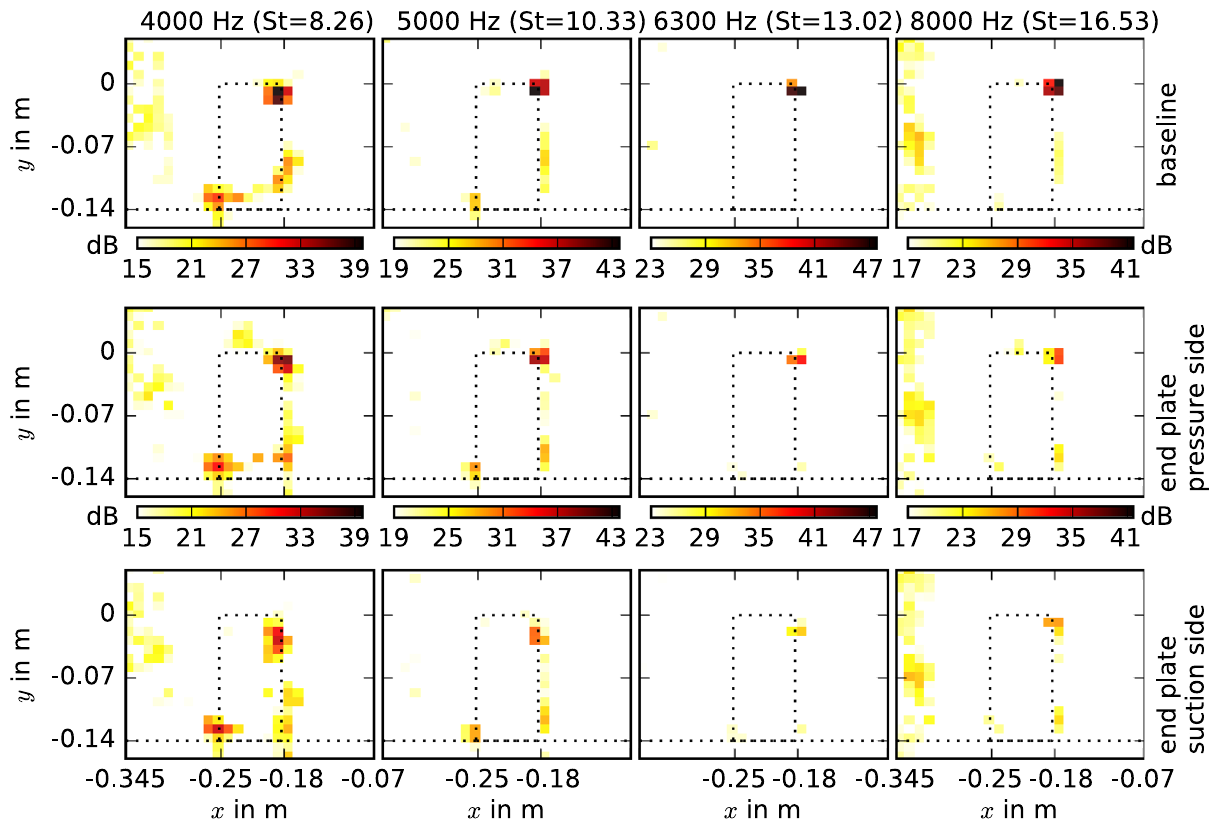
Figure A1. Third octave sound maps obtained at Re = 150,000 and 10 (cid:1) angle of attack, top baseline con fi guration, middle end plate pressure side, bottom end plate suction side, fl ow from left to right, black dotted line represents airfoil and wall, view on the suction